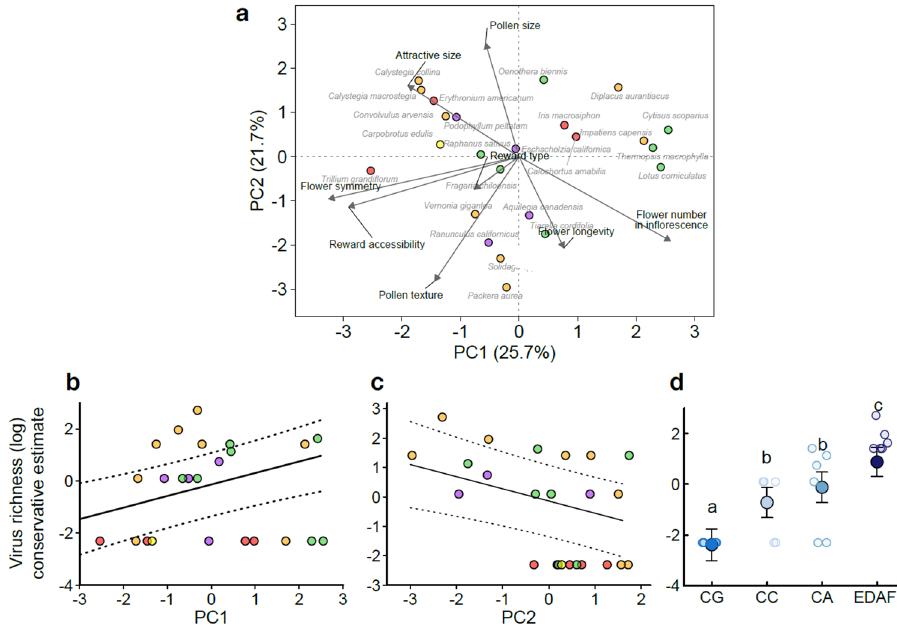
Fig. 2 Surveyed plant species varied widely in fl oral and pollen grain traits, and these, along with geographic region, predicted the conservative estimate of virus richness in pollen. a Plot of the fi rst two principal components and associated fl oral loadings (black arrows and font) across plant species (grey font and colored dots). Direction of the arrows re fl ect the association between the higher binary value (1) of each trait category with PC1 or PC2. Plant species are shown as individual points, and colors represent the fi ve plant subclasses: orange ( Asteridae ), yellow ( Caryophillidae ), purple ( Magnoliidae ), green ( Rosidae ), red ( Liliidae ). b Floral PC1, for which higher values re fl ect multiple- fl owered in fl orescences, bilateral fl oral symmetry, and restricted access to fl oral rewards, positively predicted the log-transformed conservative estimate of virus richness (two-sided chi-squared test, P < 0.001). c Floral PC2, for which lower values re fl ect spiky and smaller pollen grains, negatively predicted the log-transformed conservative estimate of viral richness (two-sided chi-squared test, P = 0.001). For b and c , the dotted lines represent 95% con fi dence intervals. d The log- transformed conservative estimate of viral richness in each region (two-sided chi-squared test, P < 0.001). CG = California Grasslands, CC = California Coast, CA = Central Appalachia, EDAFI = Eastern Deciduous Agro-forest Interface. n = 24 biologically independent pollen samples. Error bars represent ±1 standard error. P- values were adjusted using the Tukey method for comparing a family of four estimates. a , b , and c refer to statistically signi fi cant differences in the conservative estimate of virus richness between regions. Source data are provided as a source data fi